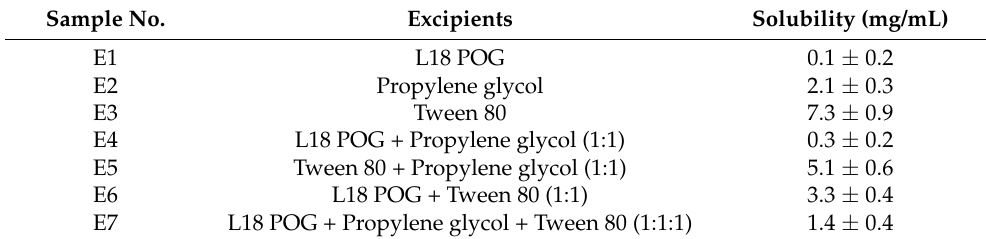
Table 1. Drug–excipient solubility study. Data presented as mean ± SD (n = 3). Sample